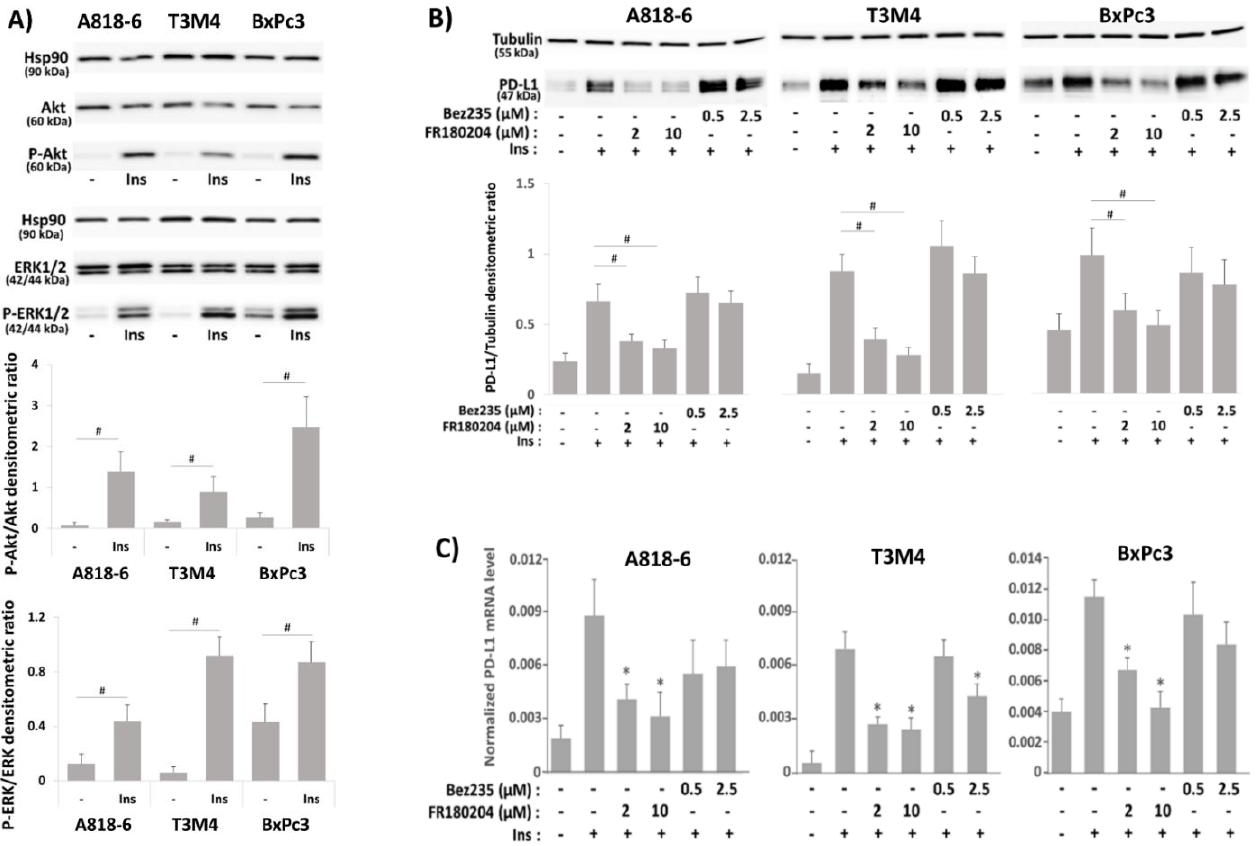
Figure 3. Signal transduction underlying the effect of insulin on PD-L1 expression in PDAC cells. ( A ) Serum-starved A818-6, T3M4, and BxPc3 cells were either left untreated or were treated for 20 min with 0.1 IU/mL insulin. ( B , C ), Serum-starved A818-6, T3M4, and BxPc3 cells either pretreated with the ERK1/2 inhibitor FR180204 (2 µM or 10 µM) or the PI3K inhibitor Bez235 (0.5 µM or 2.5 µM) for 1 h, or left without pretreatment were treated for ( B ) 24h or ( C ) 16 h with 0.1 IU/mL insulin or left without any treatment. ( A , B ) Western blot analysis using ( A ) anti P-ERK1/2, P-Akt, ERK1/2, Akt, and Hsp90 antibodies or ( B ) PD-L1 and tubulin antibodies. Representative blots from four independent experiments and band densitometry analyses (lower panels, # p < 0.05, n = 4) are shown. ( C ) qPCR analysis using PD-L1 and RPL13 primers was performed. PD-L1 expression was normalized to the expression level of RPL13, and data represent the mean ± SD from four independent experiments (* p < 0.03 compared to insulin treatment alone).